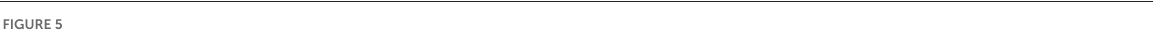
FIGURE5 ginsenosides-extracting residue polysaccharides; Control (black columns), fruits treated with deionized water; L-GRP (gray columns) and H-GRP (white columns), fruits coated with GRP at 5 and 20 mg/ml in respective. Results were presented as mean ± SD of three independent experiments ( n = 3). Different lower-case and upper-case letters indicate significant differences between and within groups, respectively, at p < 0.05 based on Tukey